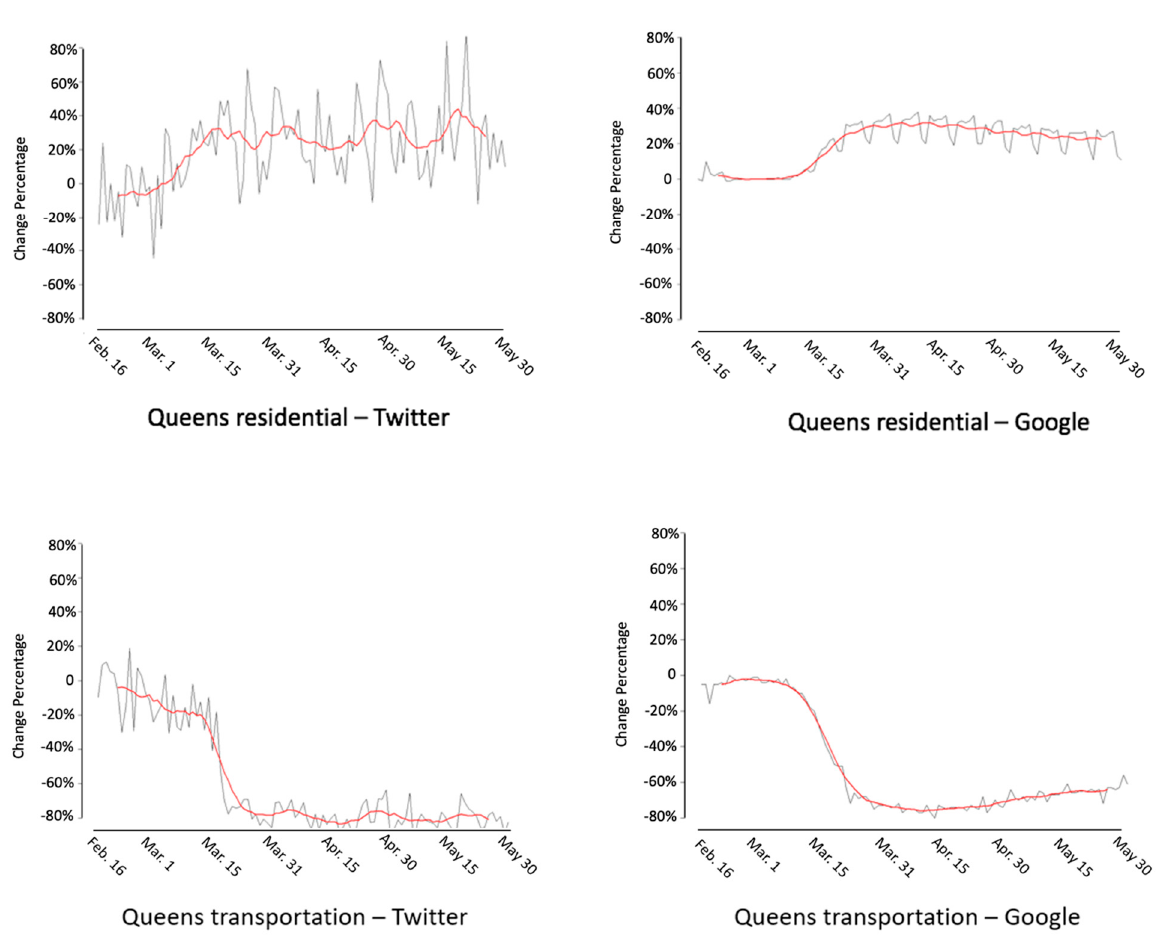
Figure 7. Twitter- and Google-based human mobility changing patterns in Queens County.